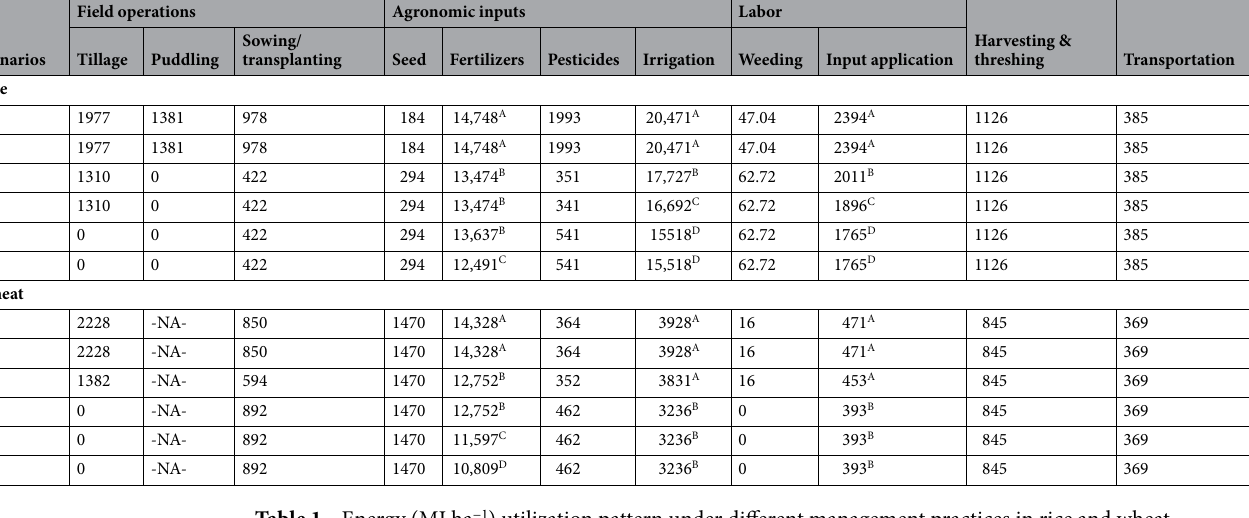
Table 1. Energy (MJ ha −1 ) utilization pattern under different management practices in rice and wheat (mean of 3-years). Values with different Upper case (A–D) letters are significantly different between each scenarios at p < 0.05 (Duncan multiple range tests for separation of mean). Sc1, business as usual or conventional tillage (CT) without residue; Sc2, CT with residue; Sc3, reduce tillage (RT) with residue + recommended dose of fertilizer (RDF); Sc4, RT/Zero tillage (ZT) with residue + RDF; Sc5, ZT with residue + RDF + GreenSeeker + Tensiometer; Sc6, Sc5 + Nutrient expert.